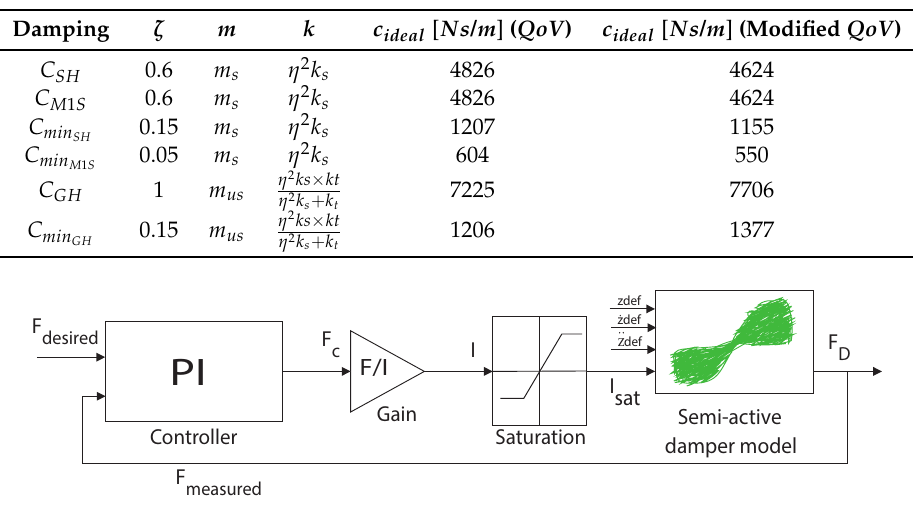
Table 6. Values for damping coefficients computing.